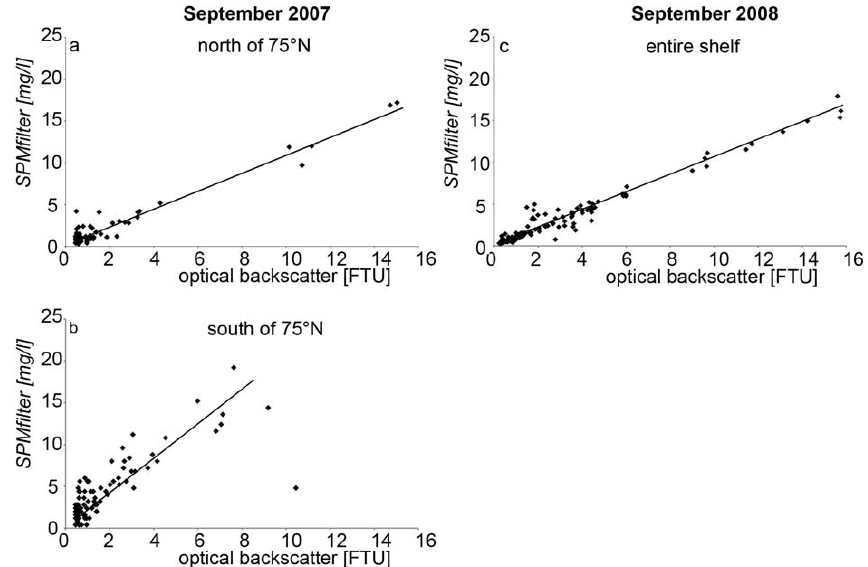
738 Fig. 5. Linear relation between concentrations derived from filtered water samples (SPM filter ) [mgL − 1 ] and optical backscatter measure- Interannual variability of surface and bottom sediment transport on the Laptev Sea shelf during summer - Wegner et al. ments in Formazine Turbidity Units [FTU] in September 2007 ( a : north of 75 ◦ N: R 2 = 0 . 949; p = 0 . 01; n = 101; b : south of 75 ◦ N: R 2 = 0 . 889; p = 0 . 01; n = 86) and in 2008 ( c : R 2 = 0 . 96; p = 0 . 01; n = 154).